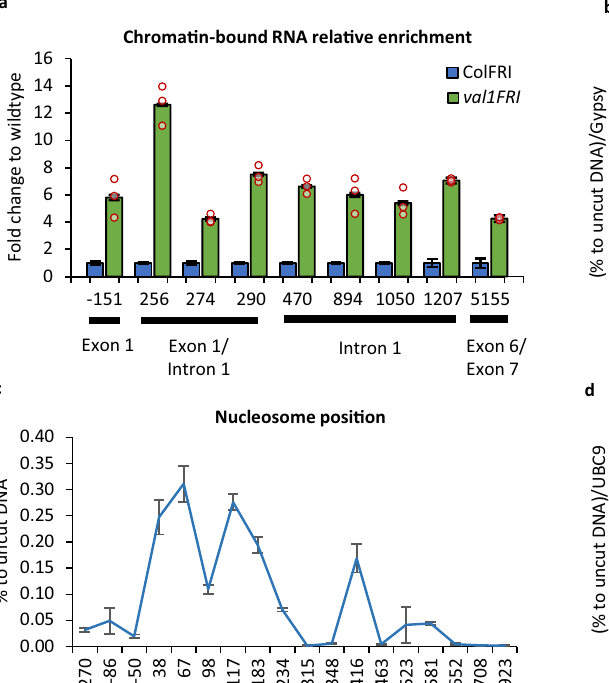
shows the beginning of the amplicon relative to FLC TSS, amplicon 0=TSS. N =2 biologically independent samples (separate seedlings ’ plates), error bars=SEM. Lines below the axis indicate regions of increased low-salt nucleosome extrac- tability in val1 shown in b . d Chromatin accessibility at FLC measured as FAIRE enrichment. Shown as % recovery to non-crosslinked sample (UN-FAIRE) and rela- tive to UBC9 . X-axis shows the beginning of amplicon relative to TSS, amplicon 0=TSS.Statistics are calculated from the Student t -test in comparison wildtype vs val1 forallampliconsindividually. N =2biologicallyindependentsamples(separate seedlings ’ plates); error bars=SEM; NV